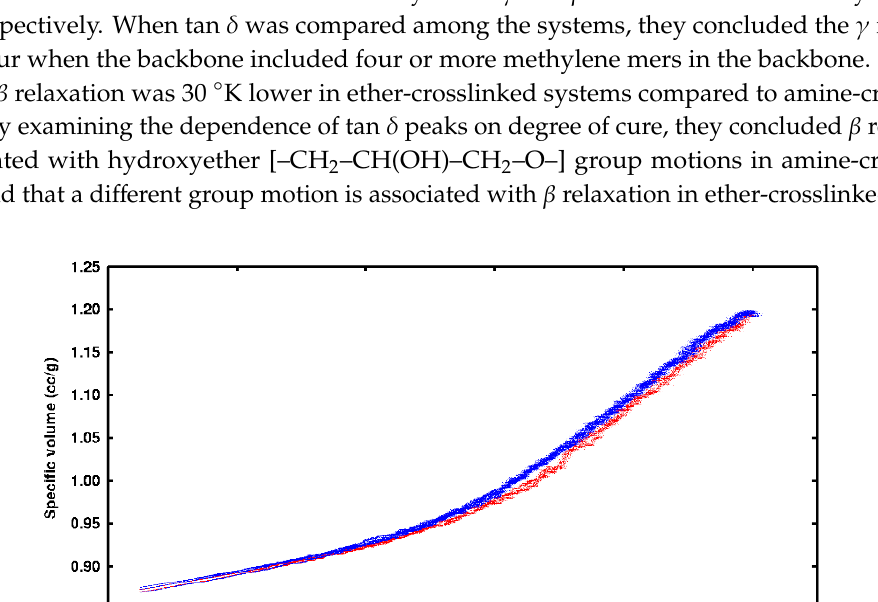
Figure 10. Specific volume as a function of temperature for the short-chain stoichiometric system. Data points for five cycles of heating and cooling are blue and red, respectively.